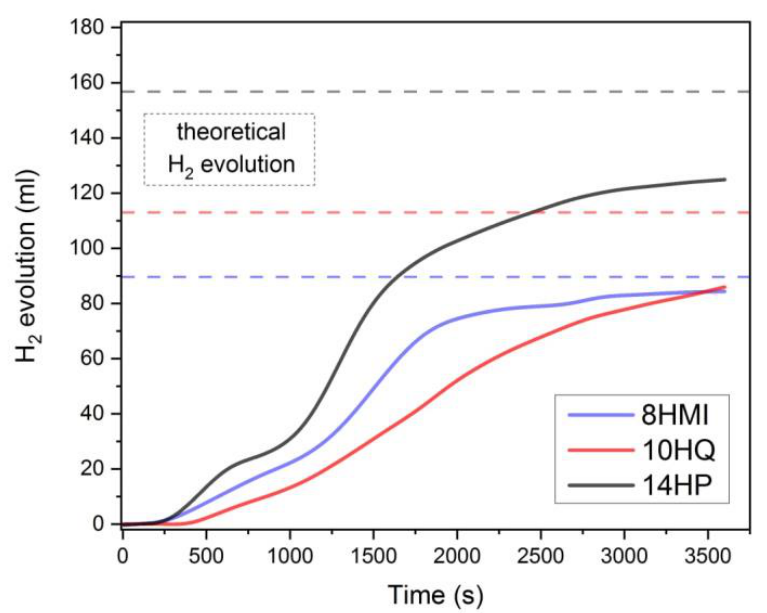
Figure 4. Kinetic curves of hydrogen evolution (reaction conditions: 240 ◦ C, 50 mg 1 wt.% Pd/C,